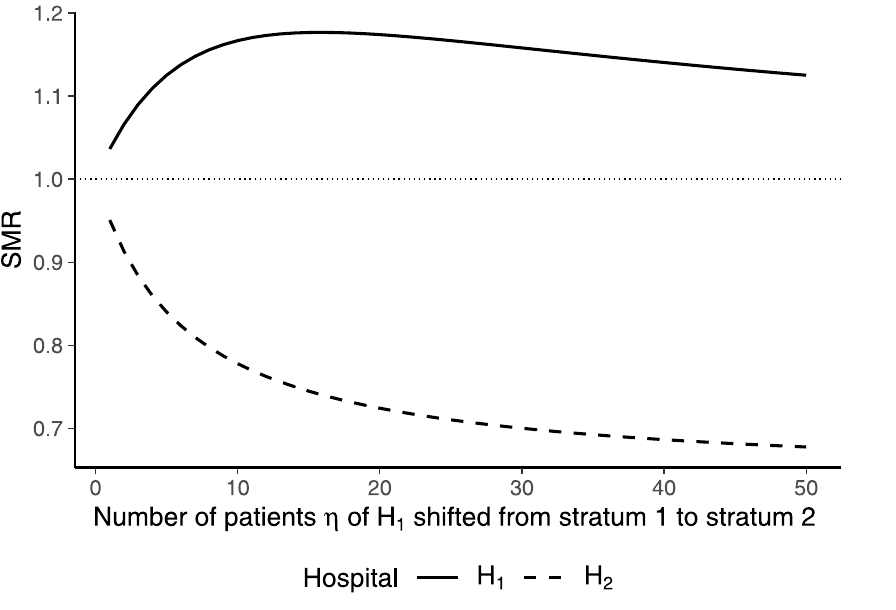
PLOS ONE | https://doi.org/10.1371/journal.pone.0257003 September 7,